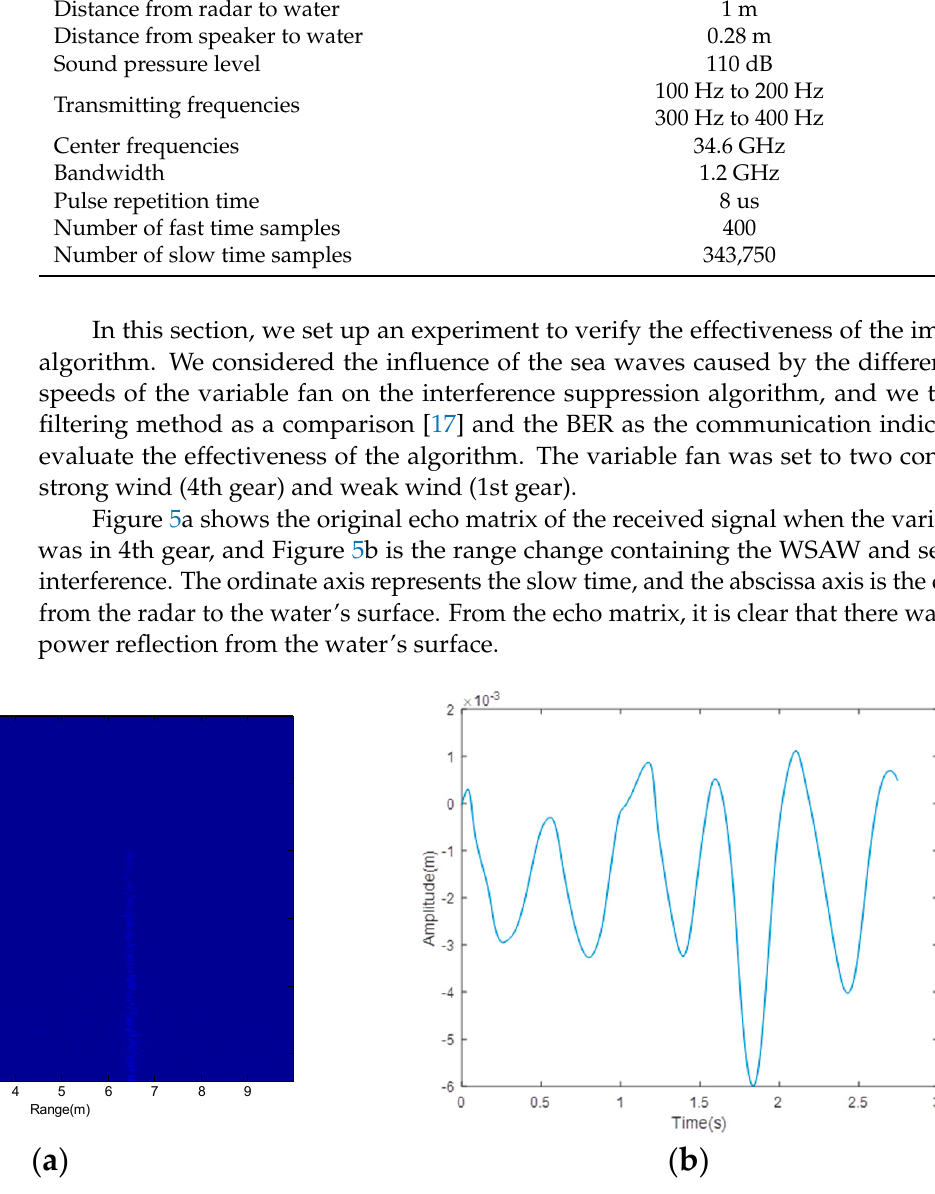
Table 1. Parameters of the cross-media communication.